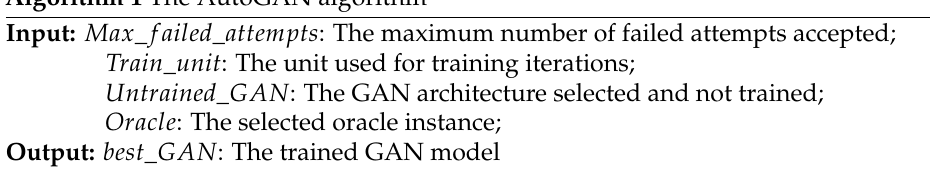
Algorithm 1 The AutoGAN algorithm